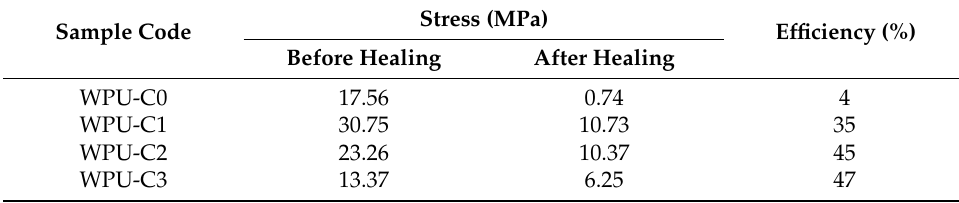
Table 3. The self-healing efficiency of waterborne polyurethanes containing chitosan.